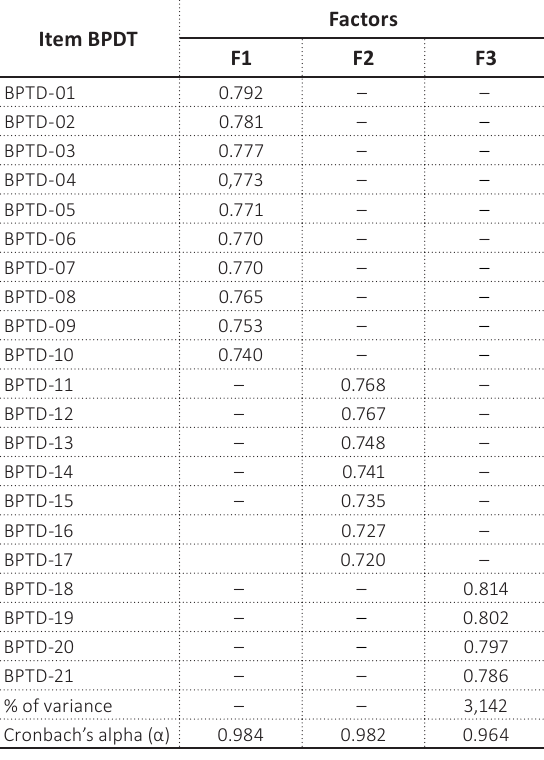
Table 2. Exploratory factor analysis results (N =